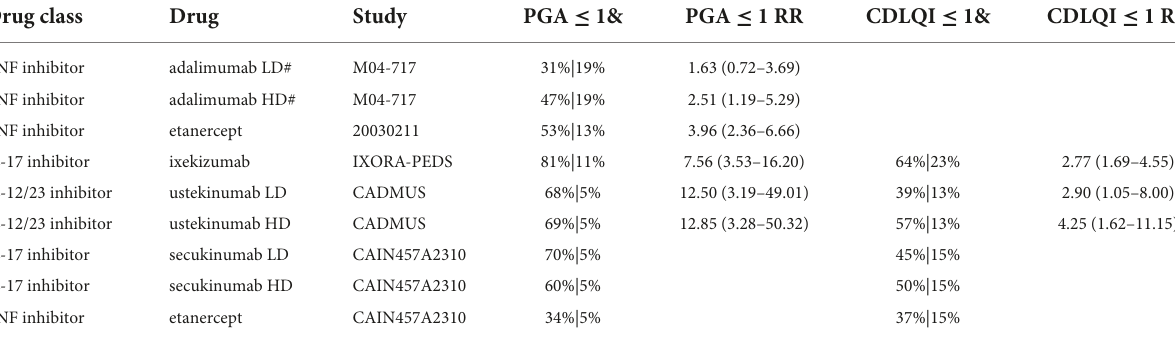
TABLE 3 Overview of PGA and CDLQI data at 3 months in RCTs in children with psoriasis. Drug